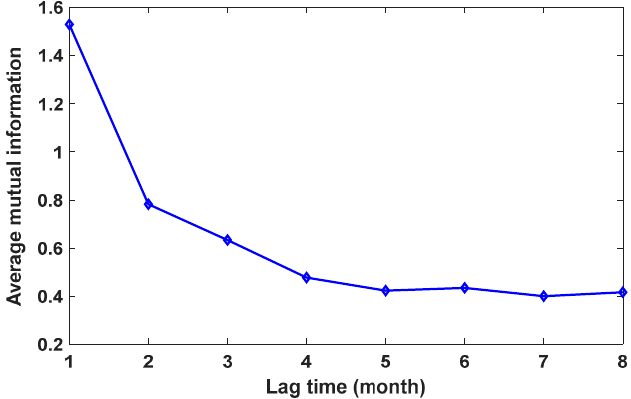
Figure 4. Average mutual information (AMI) function of the water consumption time series.